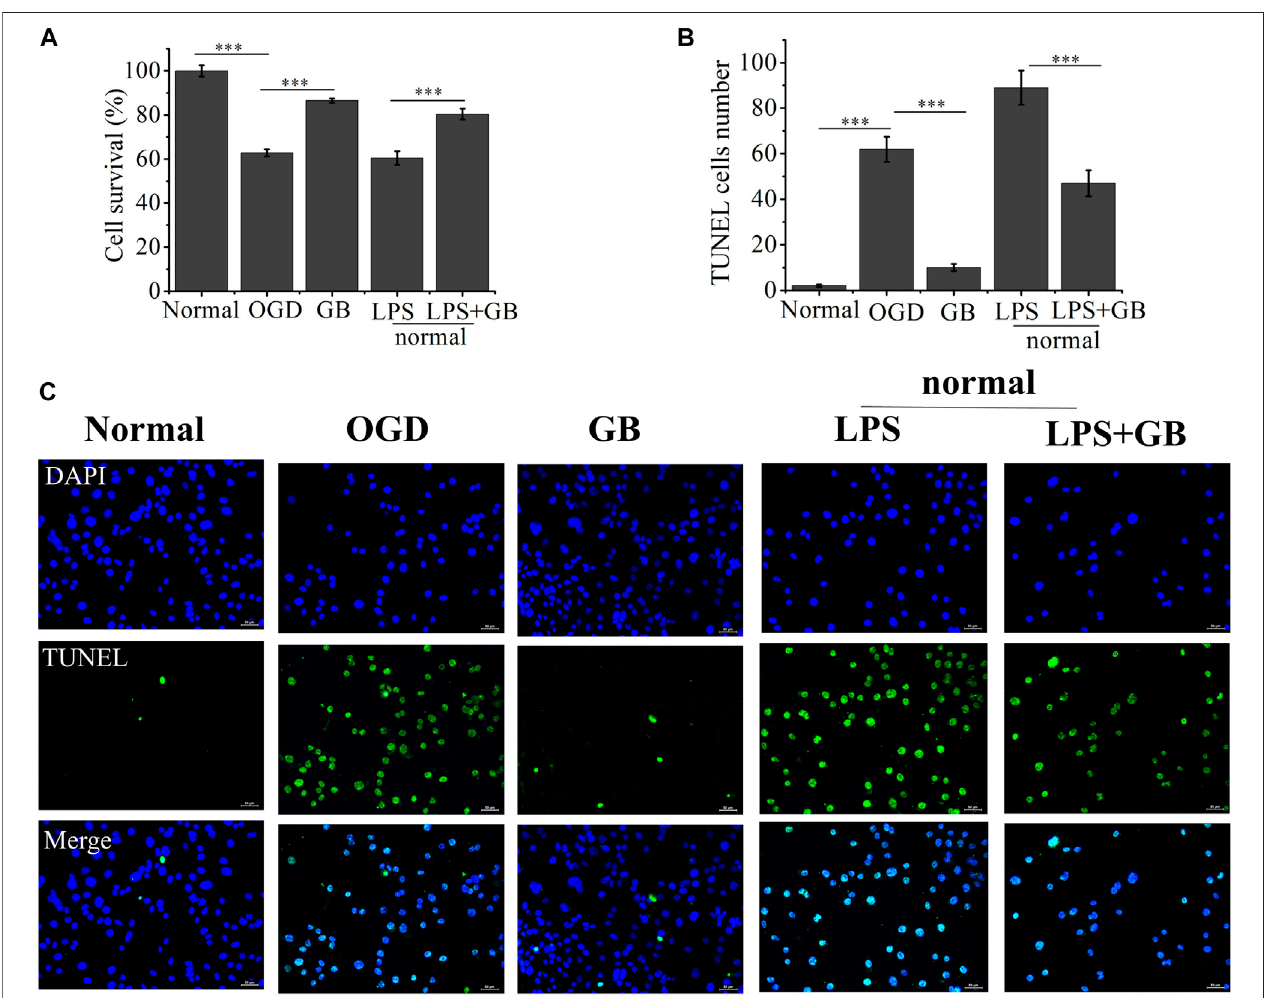
FIGURE 2 | (A) The cell viability rate of Oxygen-Glucose Deprivation (OGD) cells treated with Ginkgobalide B (GB) and normal cells treated with Lipopolysaccharides(LPS)andthecombinationofLPSandGB.Datarepresentedthemean ± SD( n (cid:1) 5),*** p < 0.001 (B) QuantitativeanalysisonthenumberofTUNEL- positive of OGD cells treated with GB and normal cells treated with LPS and the combination of LPS and GB. Data represented the mean ± SD ( n (cid:1) 3), *** p < 0.001 (C) The images of TUNEL positive cells in different groups, the scale bar is 50 μ m and applies to all fi gure parts.